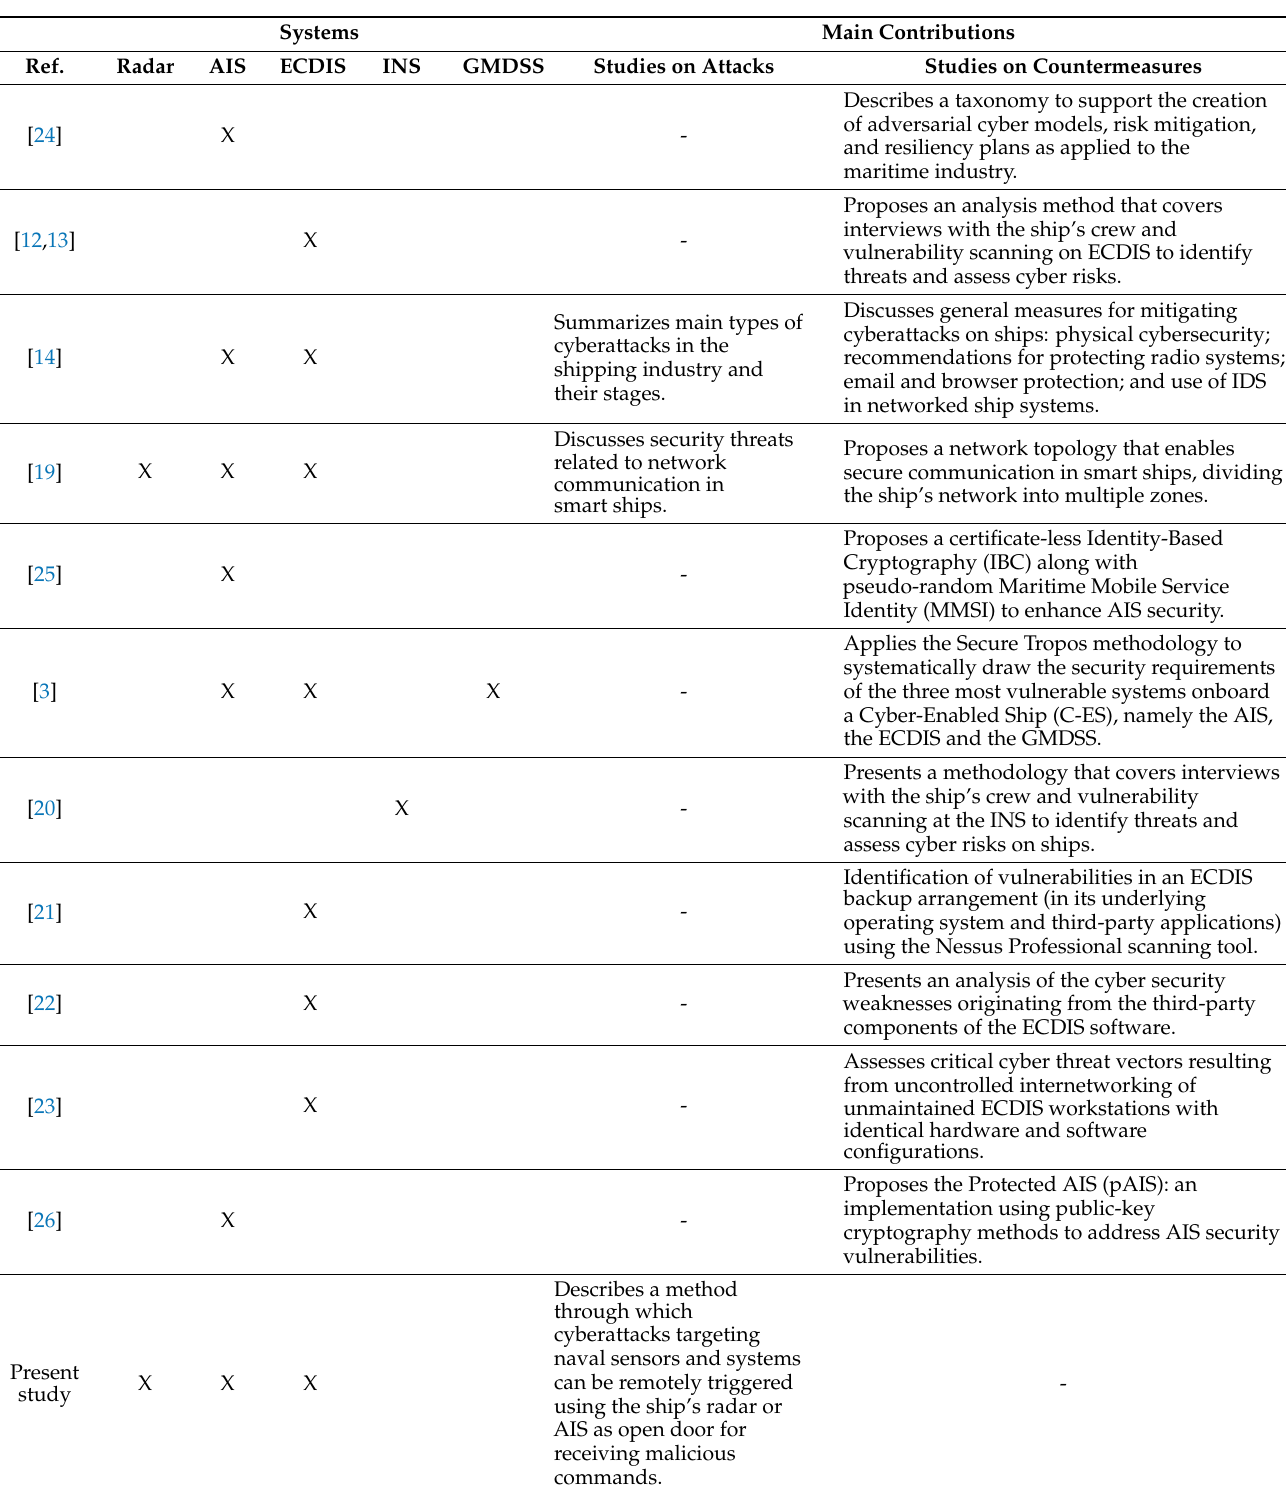
Table 1. Main topics addressed by the related works and by the present